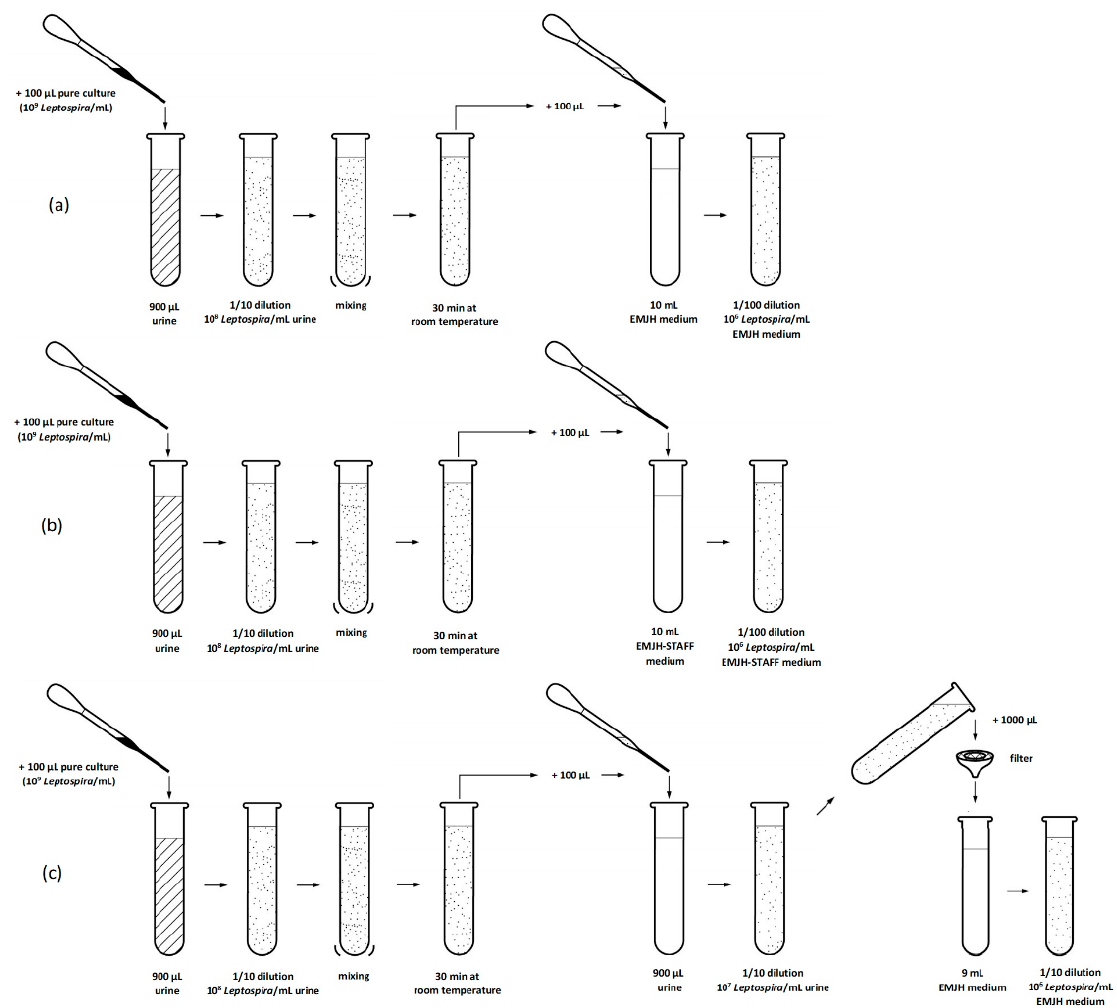
Figure 1. Experiment 1: Process of culture preparation ( a ) in EMJH medium, ( b ) in EMJH-STAFF medium and ( c ) with filtration of each urine sample.